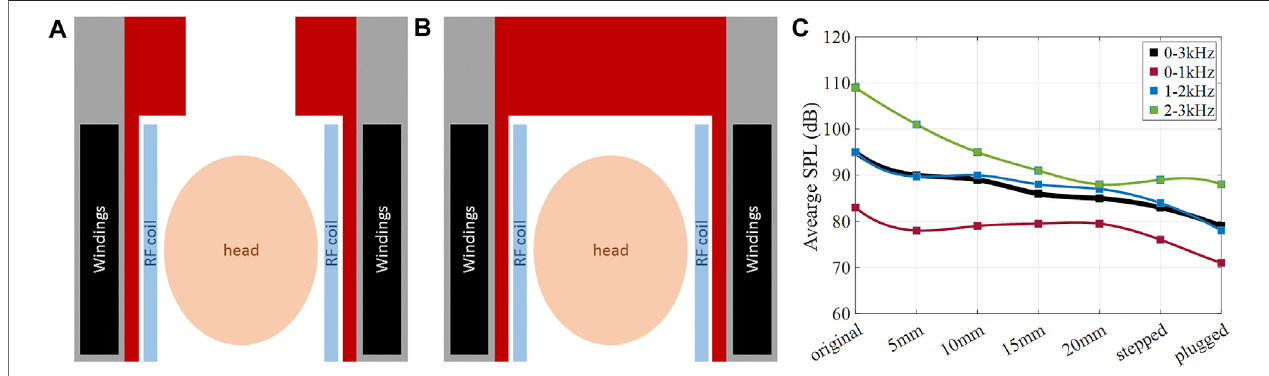
FIGURE 8 | Noise reduction with ceramic layer of various shapes. 2D sketch of the head gradient coils setup with (A) a stepped ceramic insert, (B) a ceramic endcap. (C) Simulated average SPLs for the studied con fi